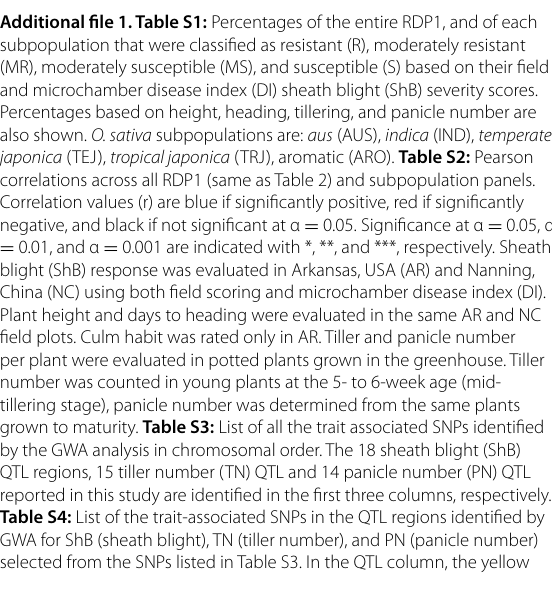
Table S4: List of the trait-associated SNPs in the QTL regions identified by GWA for ShB (sheath blight), TN (tiller number), and PN (panicle number) selected from the SNPs listed in Table S3. In the QTL column, the